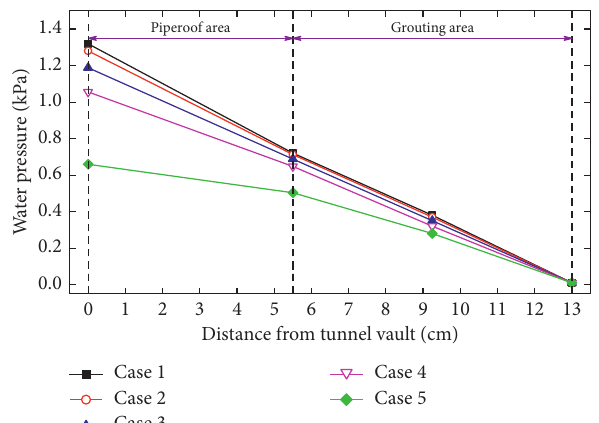
Figure 20: Variation curve of the water pressure above the tunnel vault with distance from the tunnel vault.